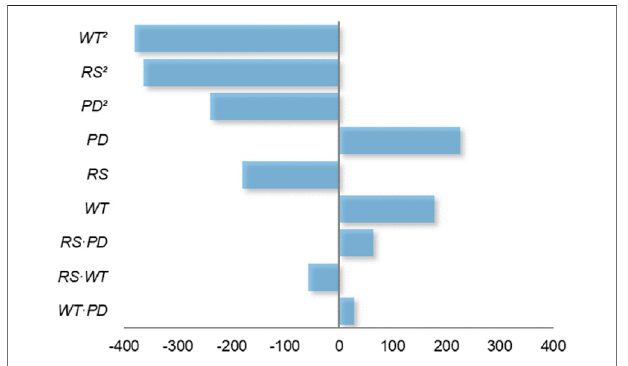
FIGURE 4 | MPR coef fi cients as feature importance scores.